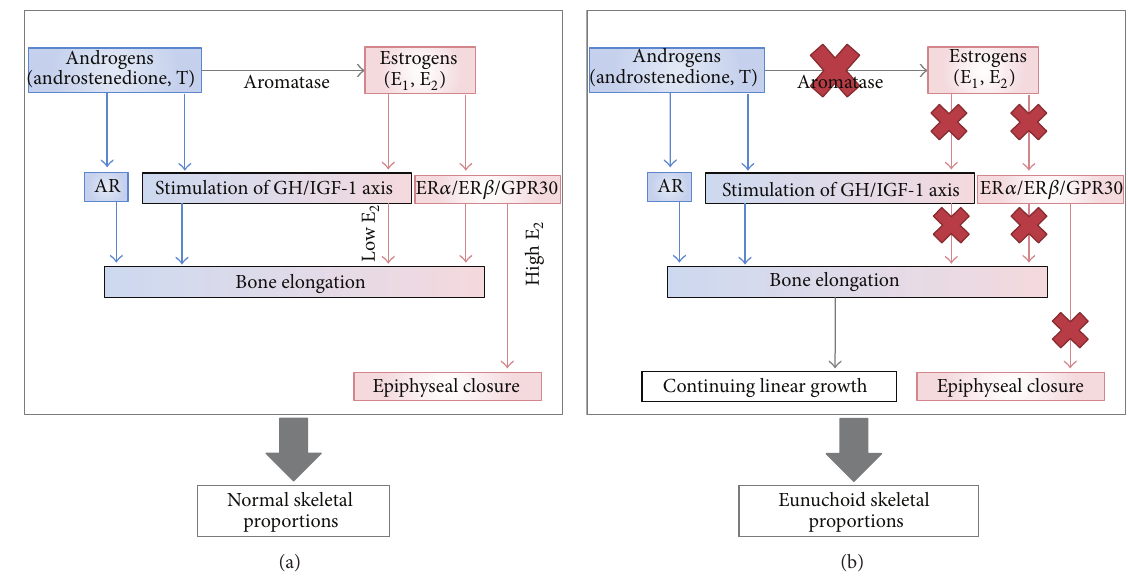
Figure 1: Direct and indirect effects of increasing circulating estrogens and their depletion on the growth plate (a), and effects of estrogen deprivation on bone elongation and epiphyseal status (b). AR: androgen receptor; E1: estrone; E 2 : estradiol; T: testosterone; ER- 𝛼 : estrogen receptor alpha; ER- 𝛽 : estrogen receptor beta; GPR30: membranous-G-protein-coupled estrogen